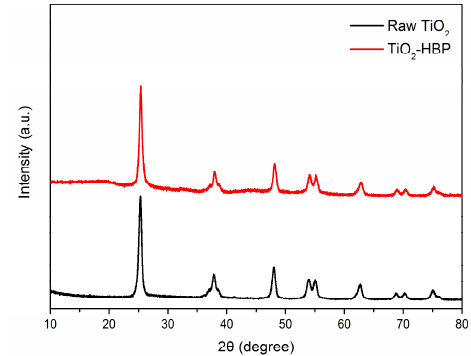
Figure 6. X-ray diffraction (XRD) spectra of raw TiO 2 and TiO 2 -HBP.